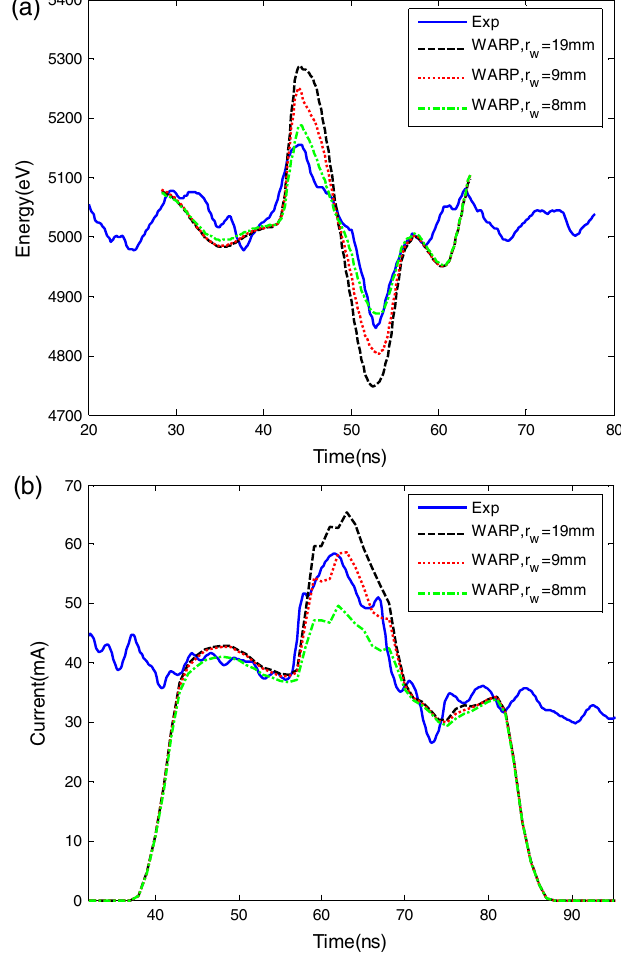
FIG. 11. (Color) Comparison of results from the experiment (blue solid lines), WARP simulations with different radii of the virtual tube: 19 mm (black dashed lines), 9 mm (red dotted lines), and 8 mm (green dash-dotted lines): (a) mean energy profiles at LC2; (b) current profiles at B3. Current profiles have been flipped to show positive current values for the convenience of indicating positive